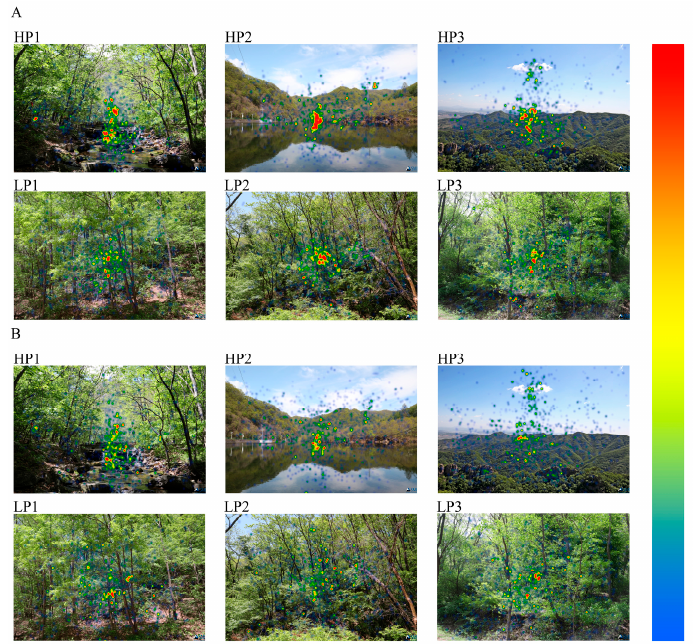
Figure 7. The distribution of participants’ gaze points during the first and second viewing of forest landscape spaces with different preferences (( A ) the first viewing, ( B ) the second viewing). Note: The color gradient bar on the right represents participants’ visual attention., different colors have different meanings, the redder the color, the higher the concern, while the bluer the color, the lower the concern. This figure was created by the author.